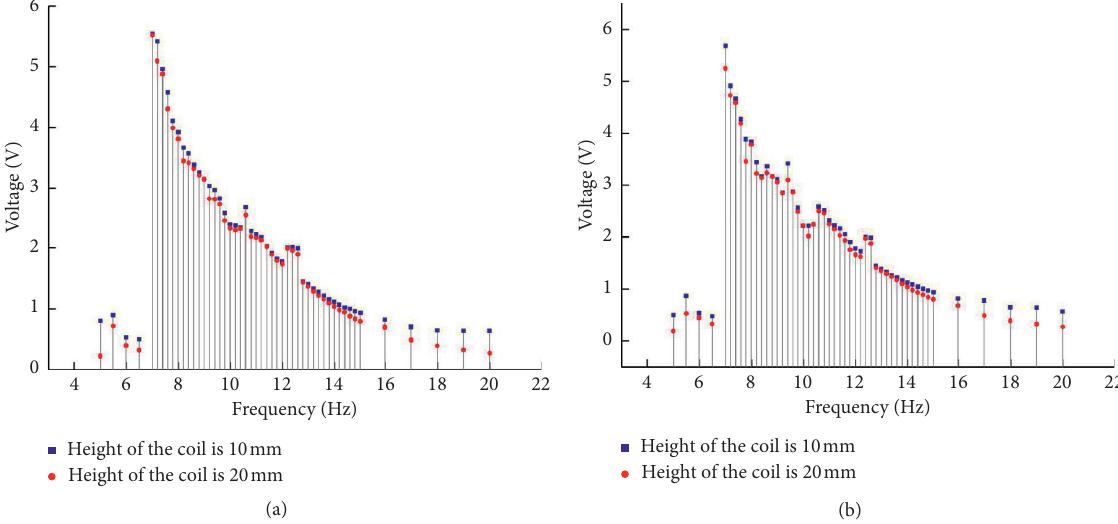
Figure 34: Relation of the voltage-frequency of the system is given when heights of coils are selected as 10mm and 20mm, respectively: (a) turns of coils are 100 turns; (b) turns of coils are 200